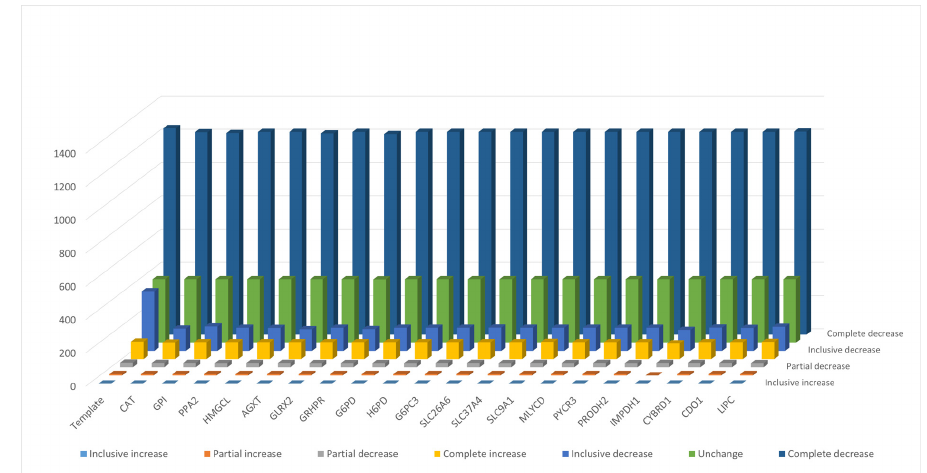
Figure 6. The number of metabolites in different categories for the template and 20 mutants. The definition of categories is presented in Supplementary Materials (Figure S4).